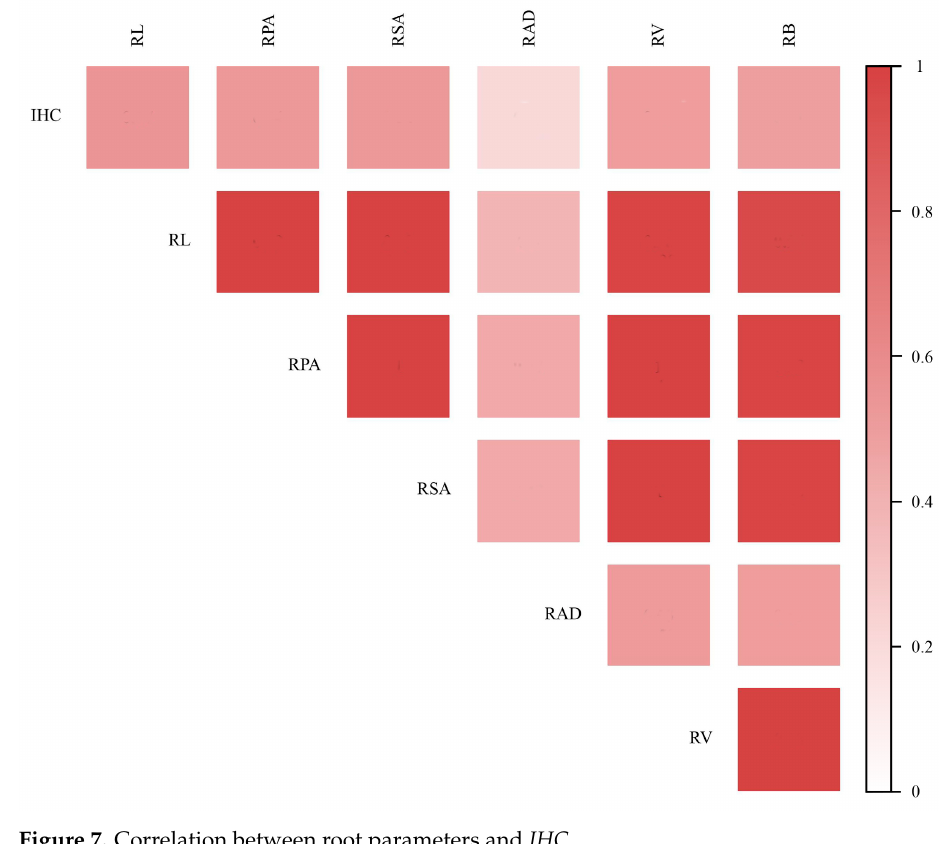
Figure 7. Correlation between root parameters and IHC .